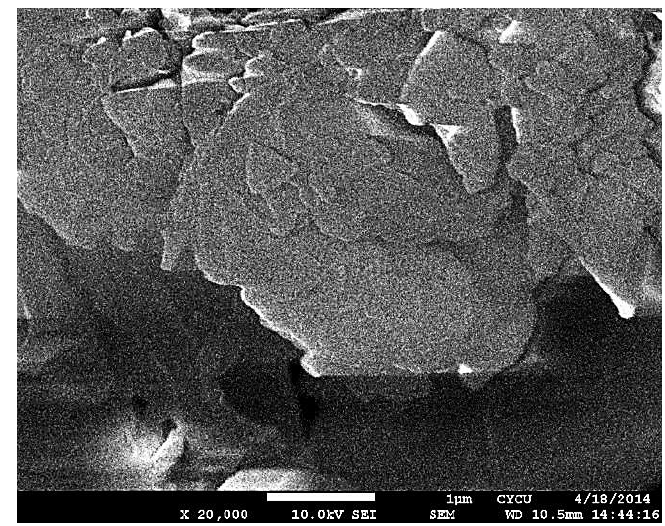
Figure 12. Scanning electron microscope (SEM) image of the neat epoxy.